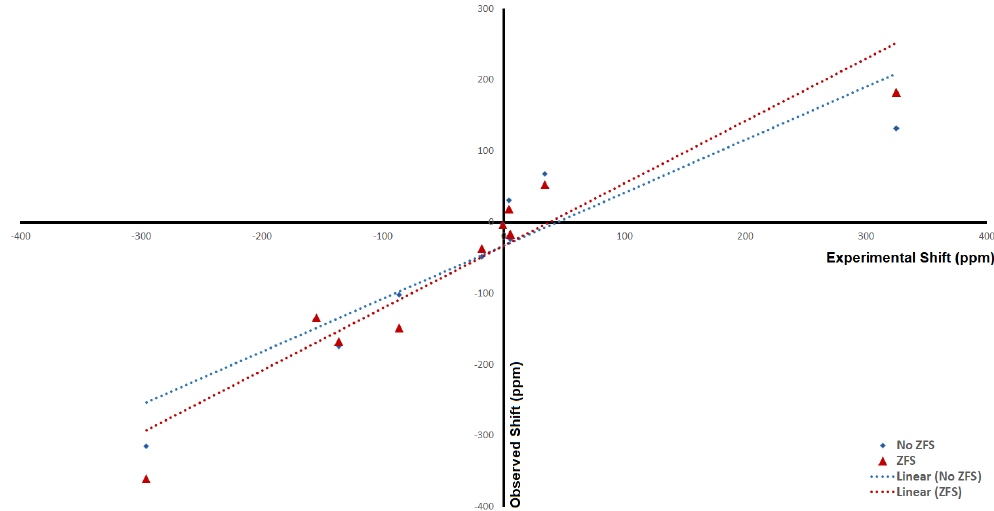
Figure 11. Calculated results against experimental